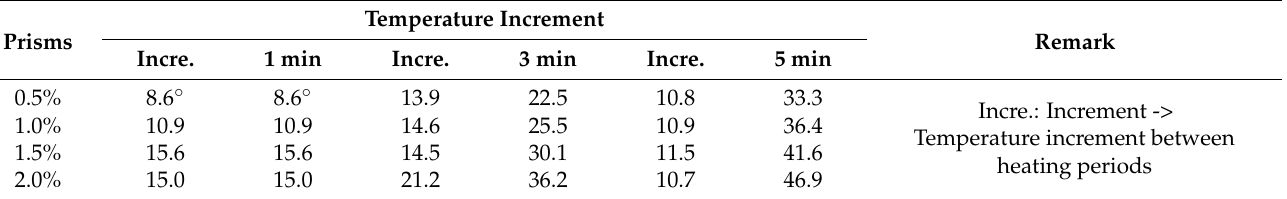
Table 3. Prisms’ temperature increments for three different heating time periods of the first 1 min, 1 to 3 min and 3 to 5